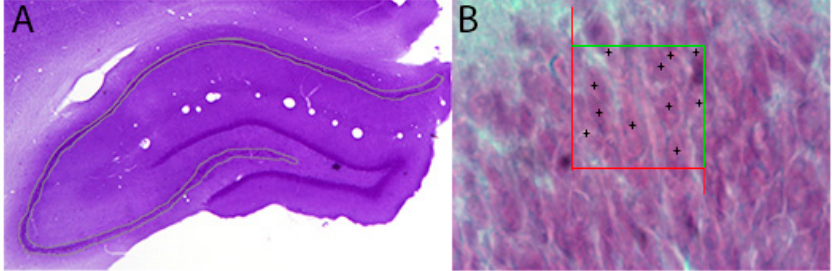
Figure 10. Total number of cells in the CA1–3 and dentate gyrus subfields of the hippocampus is estimated by the optical fractionator method. Hippocampal regions were outlined by 2.5 × objective ( A ) and then number of particles in the counting frame (30 × 30 µ m) was counted. Representative image displays the counting frame in the dentate gyrus and inclusion or exclusion of granular cells in the acceptance (green) and rejection (red) lines was shown in ( B ).